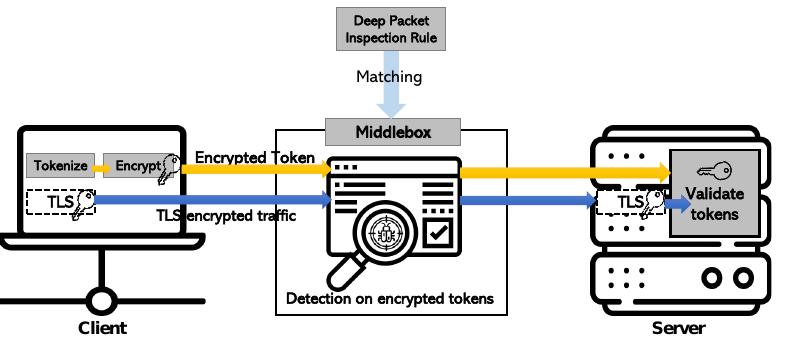
Figure 3. BlindBox system architecture as a representative example of inspection through search- able